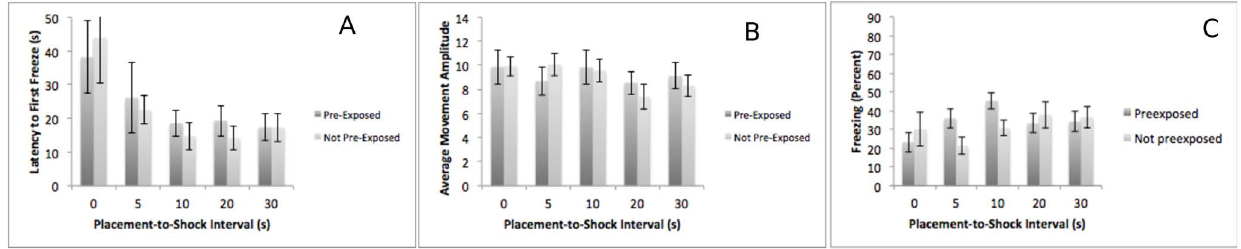
Figure 3. The results of Experiment 1–3 – contextual fear conditioning at PD 17/25/26. Subjects pre-exposed (dark bars) or not pre- exposed (light bars) to the conditioning context on day 1 do not differ in their latency to freeze (Panel A), initial movement amplitude (Panel B), or their freezing (Panel C) on test day. To specifically examine whether pre-exposure can have any effect on conditioning, as reported by Foster & Burman (2010), we separately examined the 5- and 10-s placement to shock intervals. Although only approaching significance at 5 s, there was a significant effect of pre-exposure at the 10-s placement-to-shock interval.